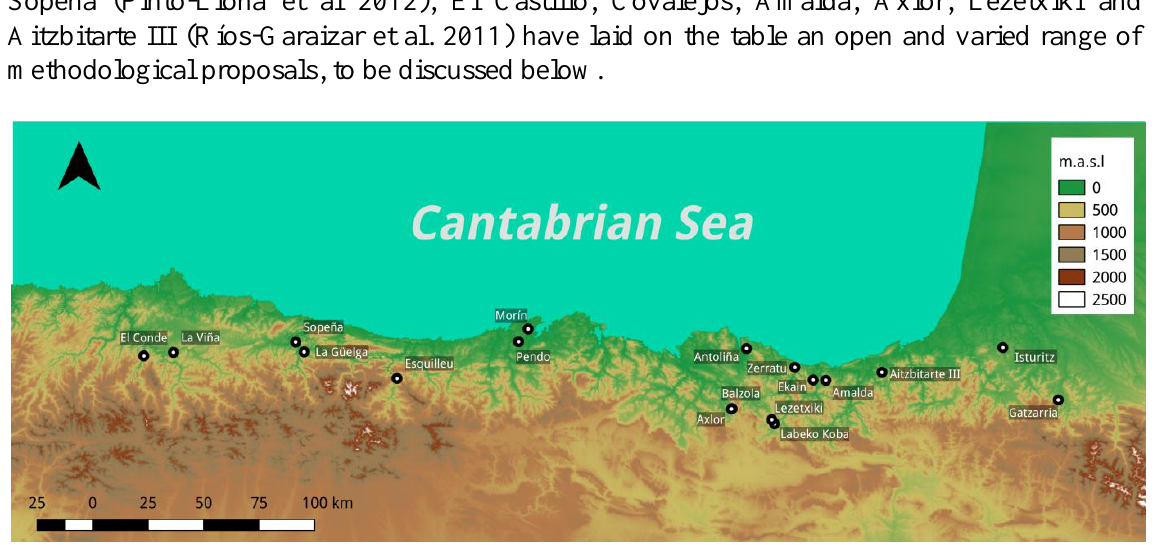
Figure 1. Map of the Cantabrian Iberian, with the cited